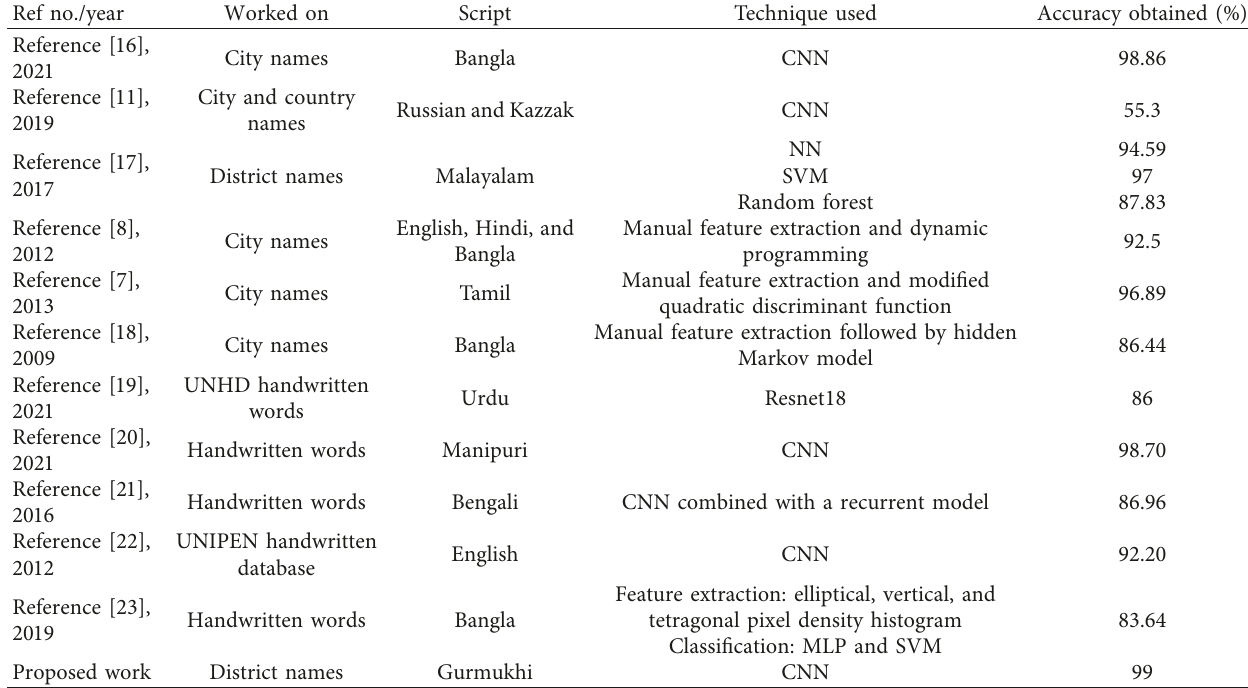
Table 4: Comparison of the work with state-of-the-art